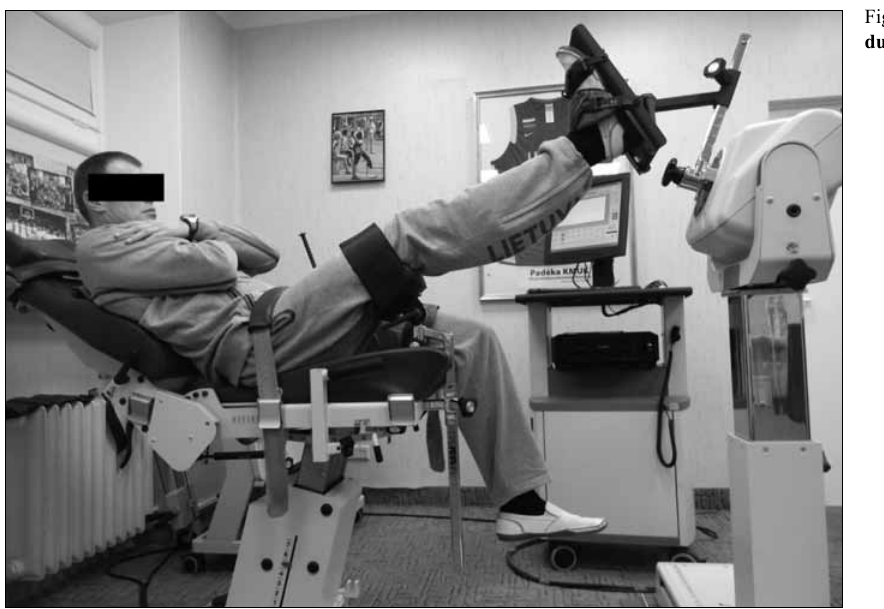
Figure 1. Patient positioning during